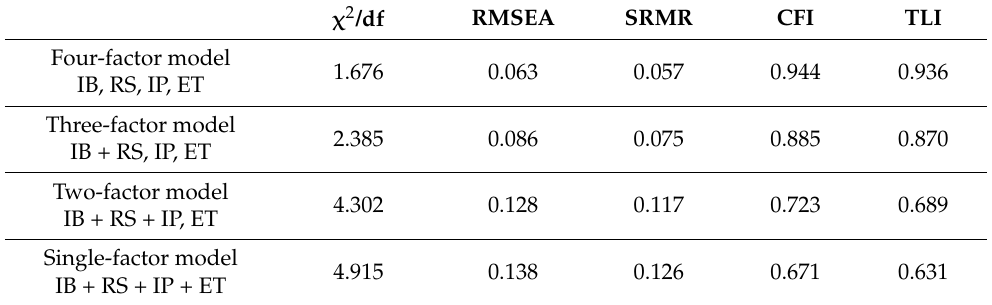
Table 2. Confirmatory factor